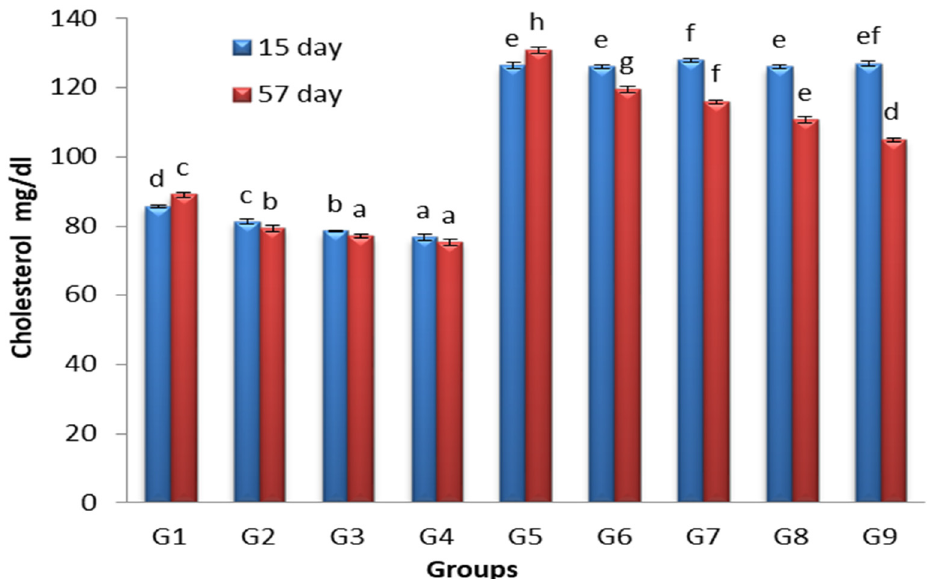
Figure 2. The influence of L. plantarum (Lp), L. casei (Lc), S. platensis (Sp) and their combination on total cholesterol (TC) level in albino mice (mg/dL) at 15 and 57 days. Error bars represent SE of mean. G1: Regular diet (RD); G2: RD + Lp + Lc; G3: RD + Sp; G4: RD + Lp + Lc + Sp; G5: high-cholesterol diet (Ch); G6: Ch + Lp + Lc; G7: Ch + Sp; G8: Ch + Lp + Lc + Sp; G9: Ch+ rosuvastatin. Bars with different superscript are significantly different ( p <